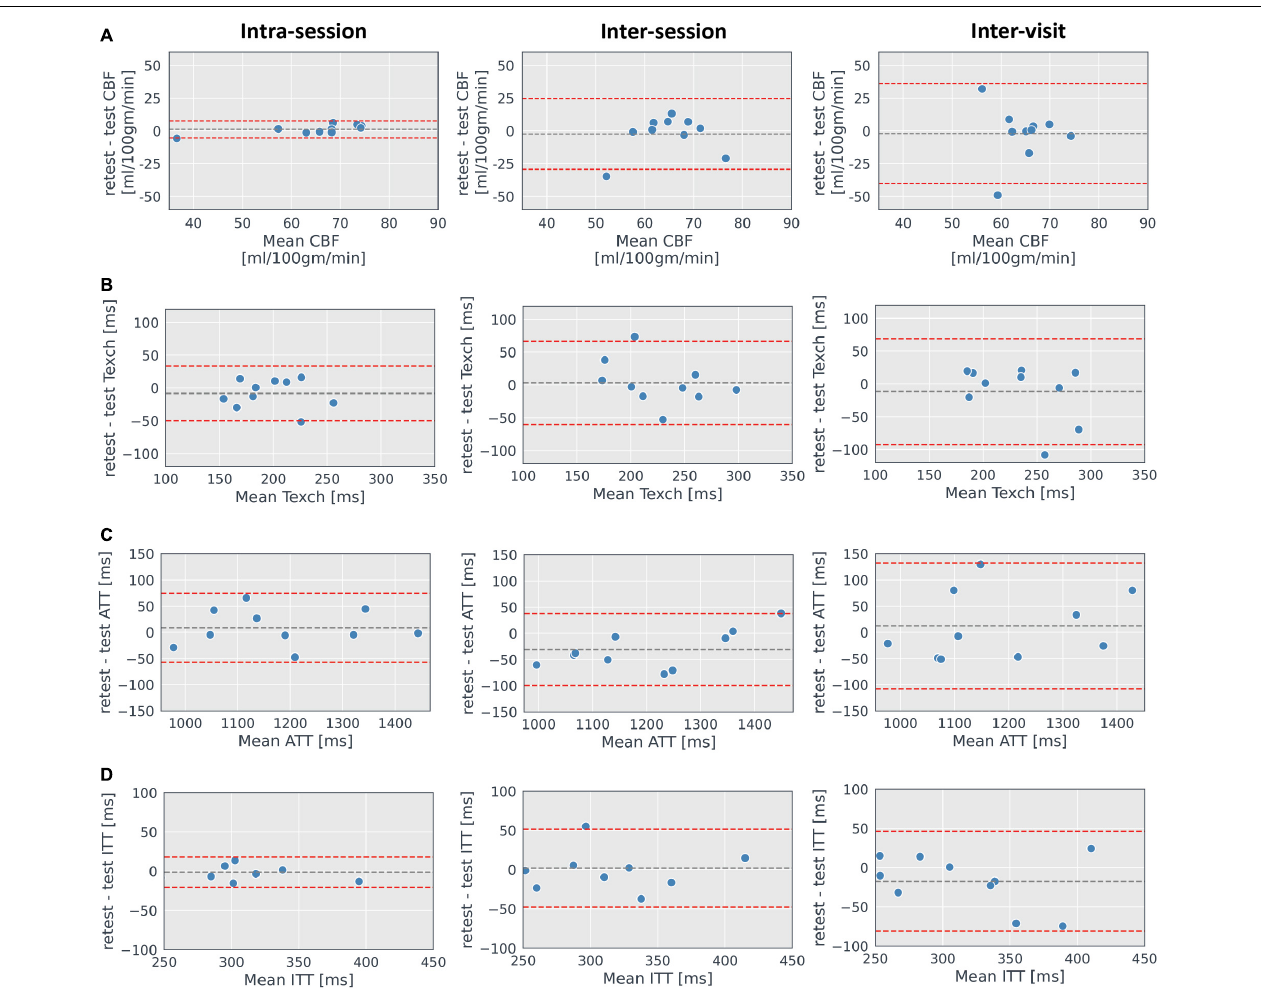
FIGURE 9 | Bland–Altman plots. Plots of mean grey matter CBF (A) , Texch (B) , ATT (C) , and ITT (D) showing the spread of the data for intra-session, inter-session and inter-visit estimated with the extended model. Grey dashed line shows the mean difference, and red dashed lines represent 1.96 × standard deviations of the mean, displaying the corresponding limits of agreement.